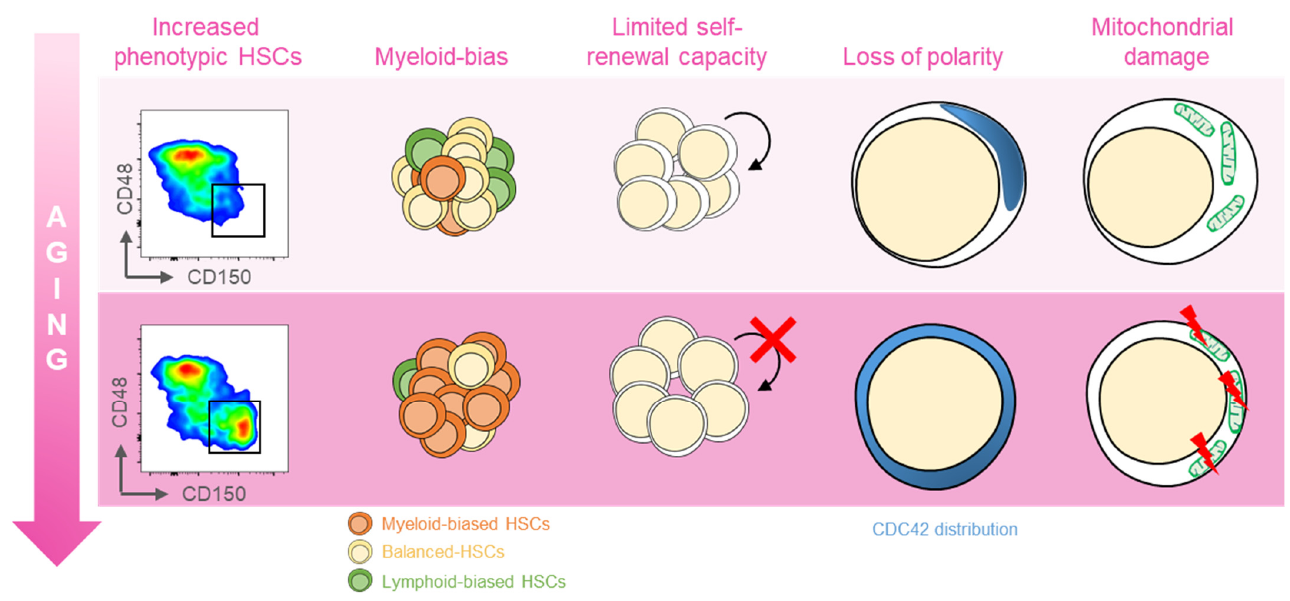
Figure 1. Features of aged HSCs. Upon aging, hematopoietic stem cells (HSCs) acquire phenotypical and functional peculiar properties. Flow cytometry analysis of the murine bone marrow shows an increase in the phenotypic HSCs (defined as c-Kit + Sca-1 + Lin − CD135 − CD48 − CD150 + ) in old (18 months old, bottom panel) mice (far left). The HSC pool includes balanced HSC, which in equal proportion differentiate in myeloid and lymphoid lineage (yellow, left); with age, the myeloid-biased differentiation prevails at the expense of lymphoid cells (left). The self-renewal capacity typical of HSCs is reduced upon aging (middle). Cytoskeletal polarity detected by CDC42 localization is lost in old HSCs where CDC42 expression is homogeneously distributed (right). Aged HSCs display the mitochondrial damage with the altered metabolism (far right).